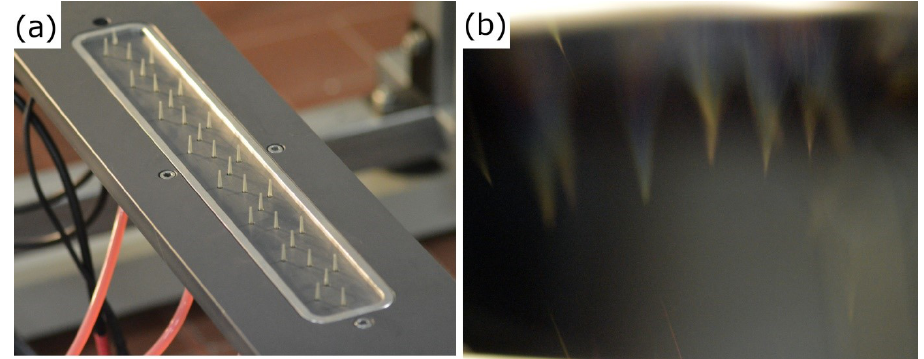
Figure 7: (a) Picture of 31-nozzle configuration plant at CNR-ISMAC Biella. (b) Picture of jet and whipping motion during a multi-nozzle